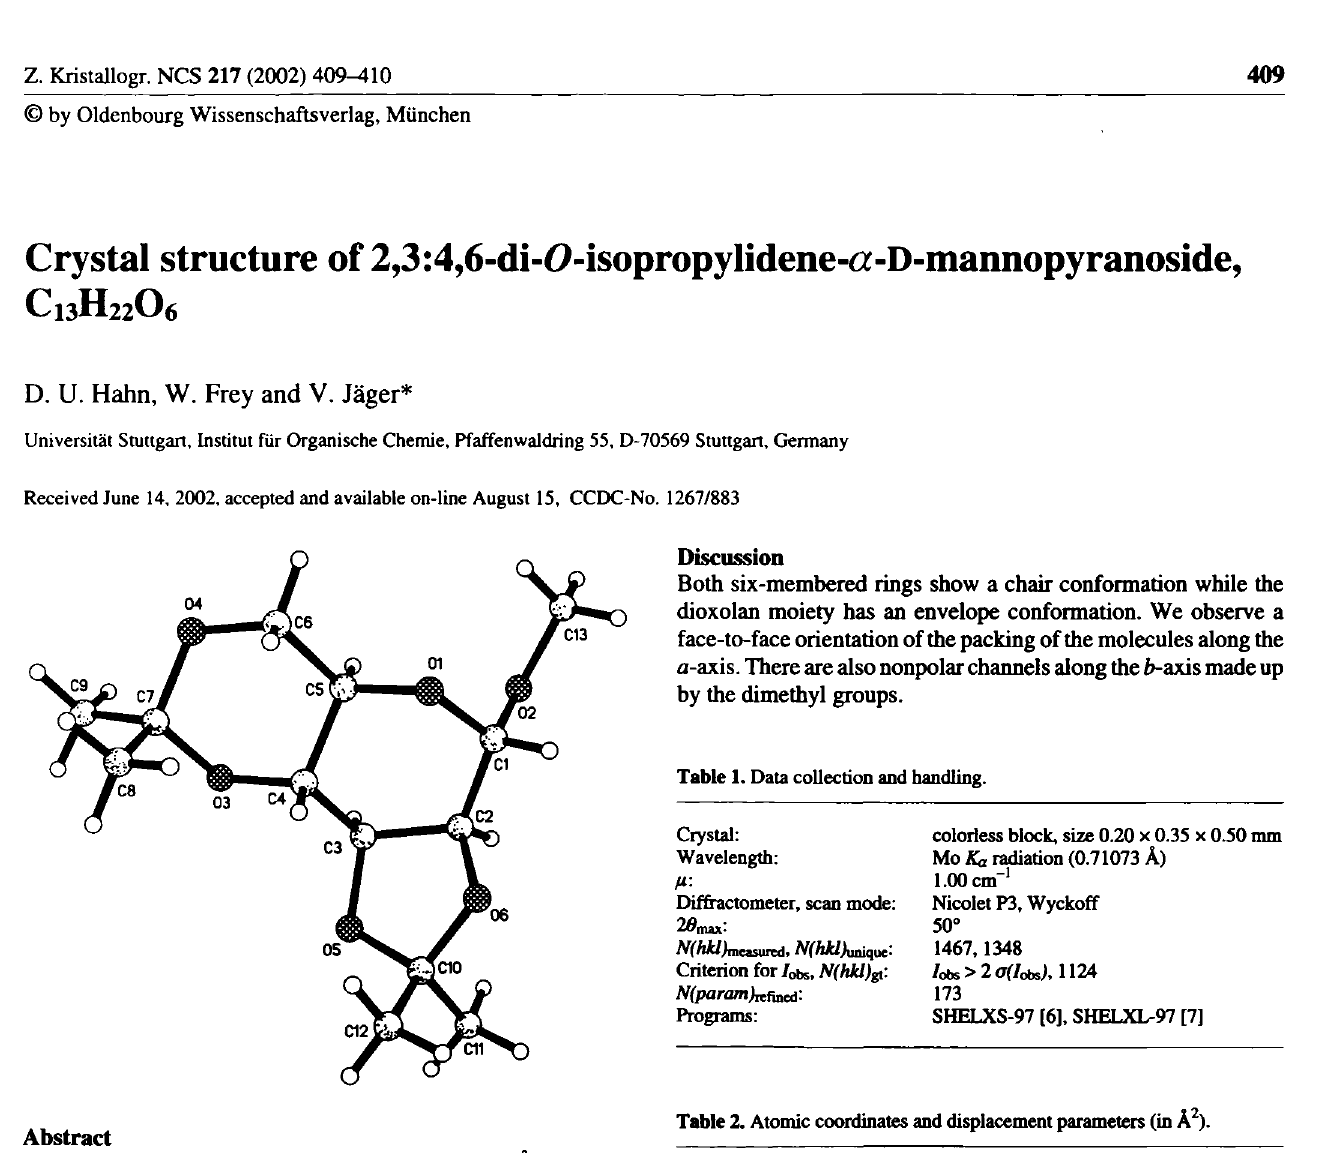
Table 2. Atomic coordinates and displacement parameters (in Â 2